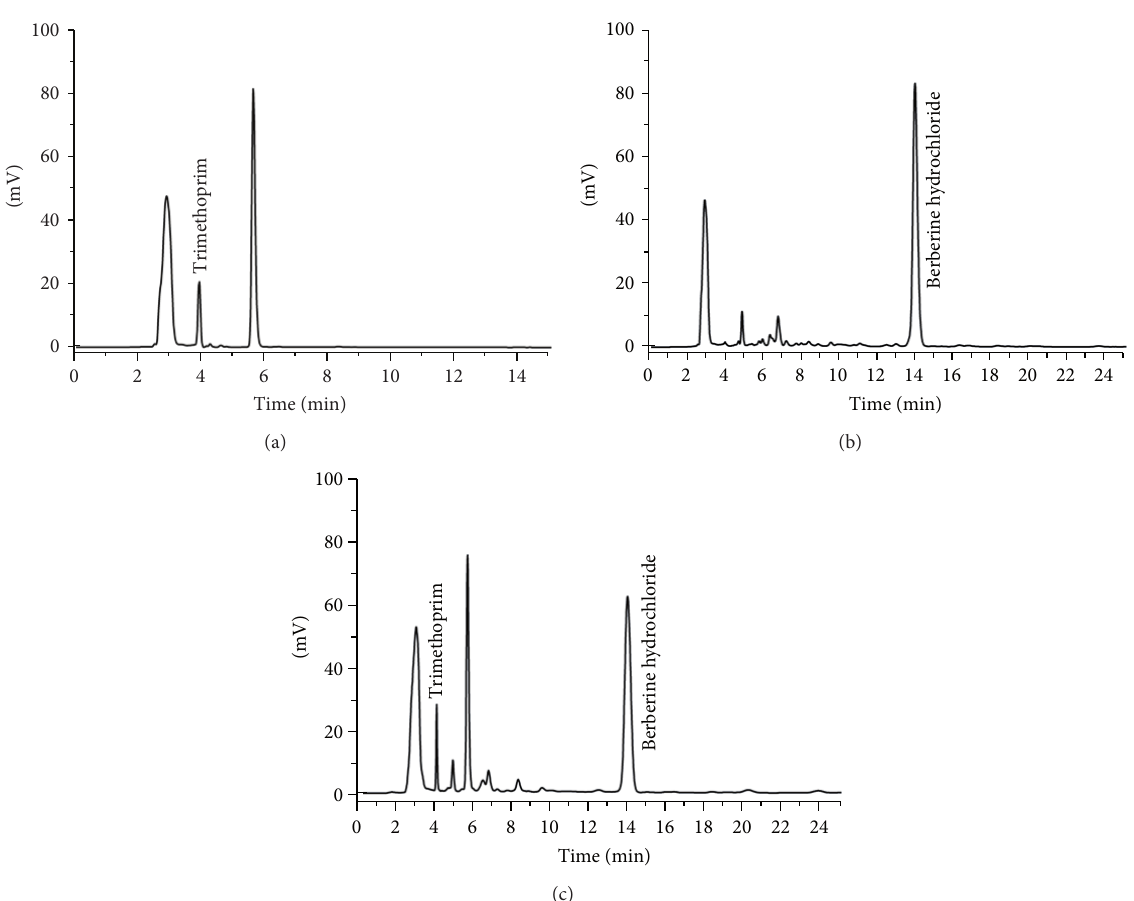
F 4: Typical HPLC chromatograms of oxidative degraded (a) trimethoprim, (b) berberine hydrochloride, and (c) combined capsule solutions.